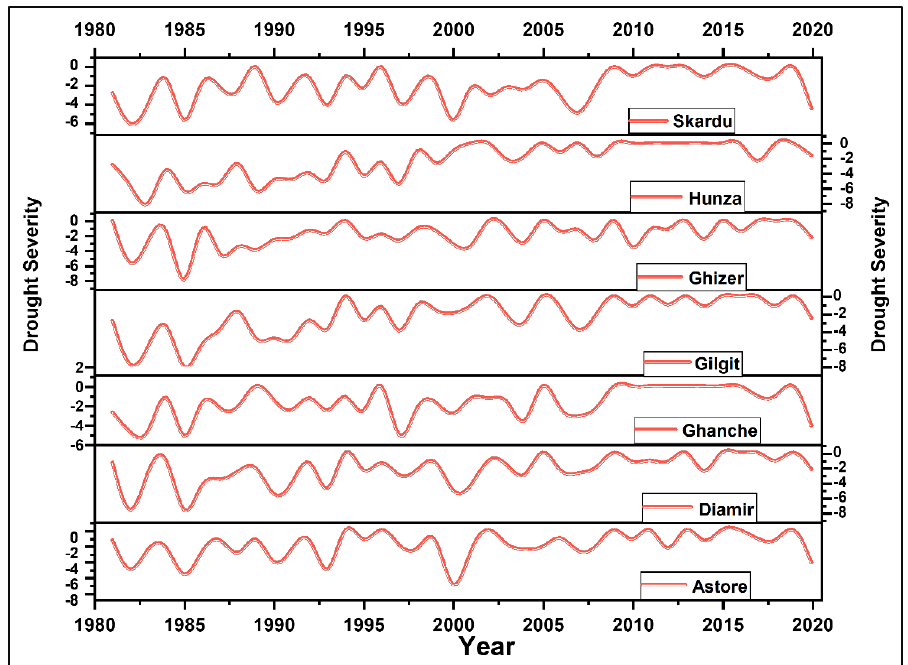
Figure 5. Drought severity for all districts.